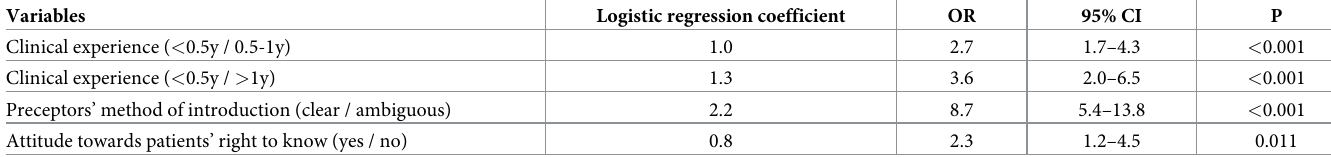
Table 4. Optimal bivariate logistic regression model for possible factors influencing how students introduce themselves to